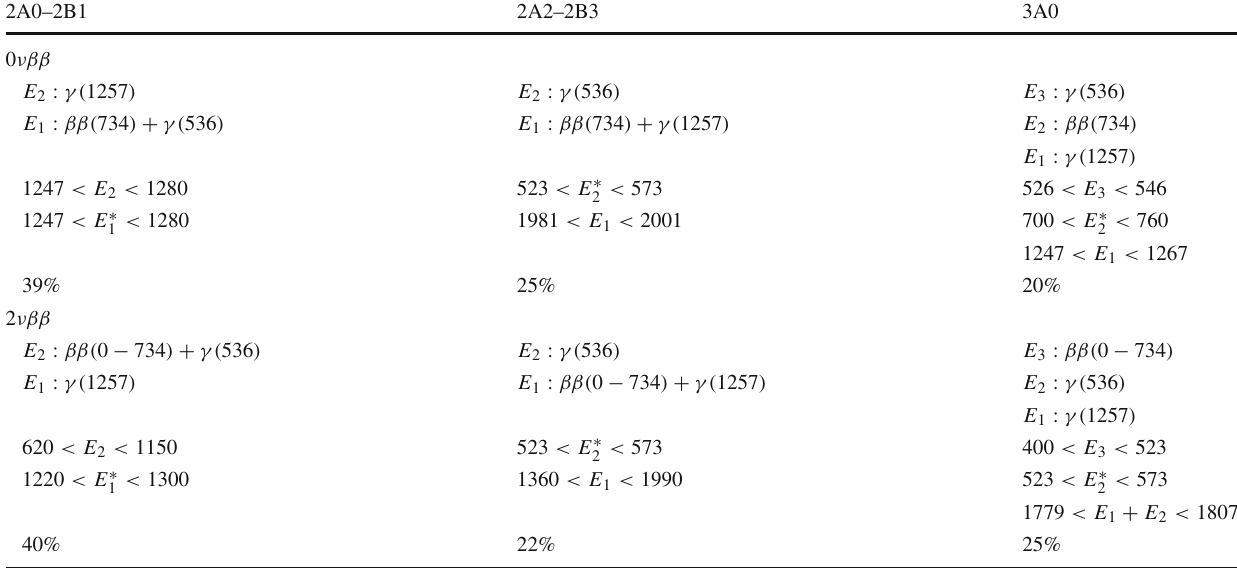
releases E 1 ≥ E 2 ≥ E 3 . The component that will be used for the fit is 2 highlighted with a ∗ superscript. For each signature the partition of the secondaries expected to contribute are listed. For each secondary we report in round brackets the expected energy release in keV. The last row reports the corresponding relative score (Eq.